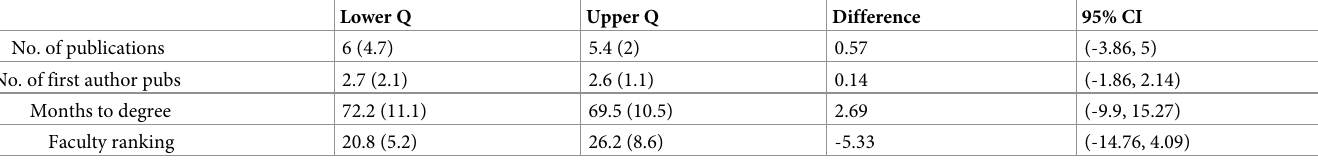
Table 5. Mean (SD) of variables in lower and upper quartiles of GRE-V and 95% CIs for their